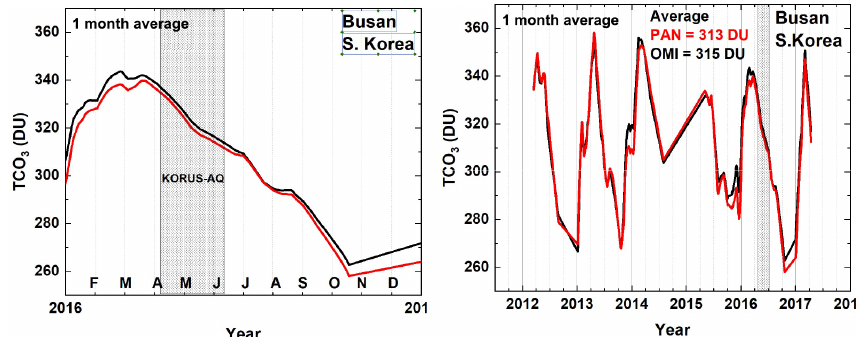
Figure A1. Monthly average values of TCO for OMI and PANDORA at OMI overpass times for Busan, South Korea. Shaded area represents the KORUS-AQ campaign period.